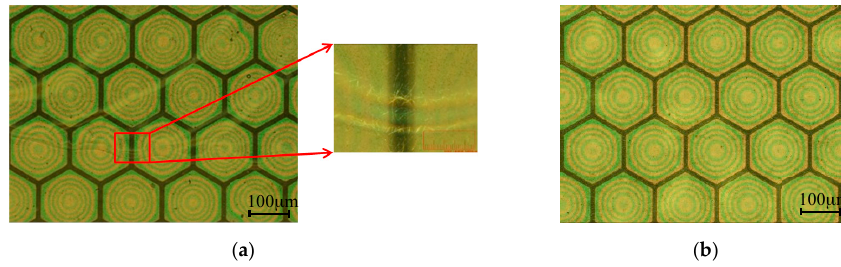
Figure 13. ( a ) Surface warpage observed on a protecting layer after the pulse-echo test; ( b ) No warpage observed on a 1 µm SU-8 protecting layer after the pulse-echo test.